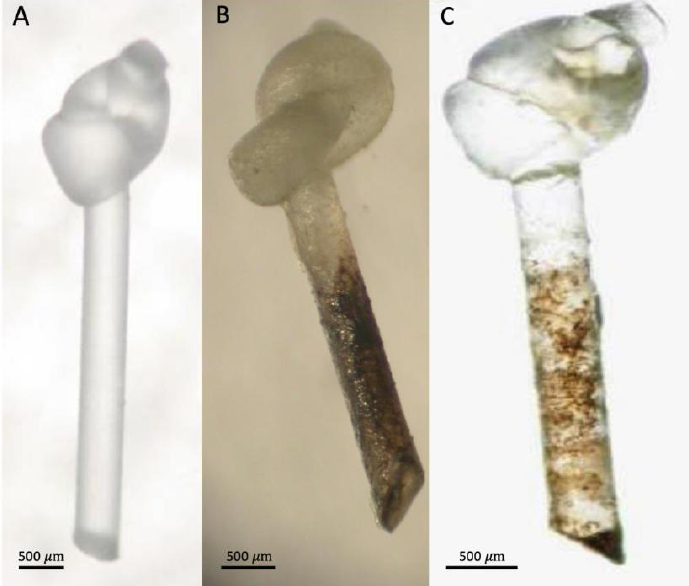
Figure 10. Examples of melanotic encapsulation response to plastic implant by G. mellonella larva naturally envenomated by H. hebetor . ( A ), initial implant, ( B ), control (untreated) larva 24 h post treatment. ( C ), envenomated larva, 24 hrs post treatment. (Source: reproduced by permission of